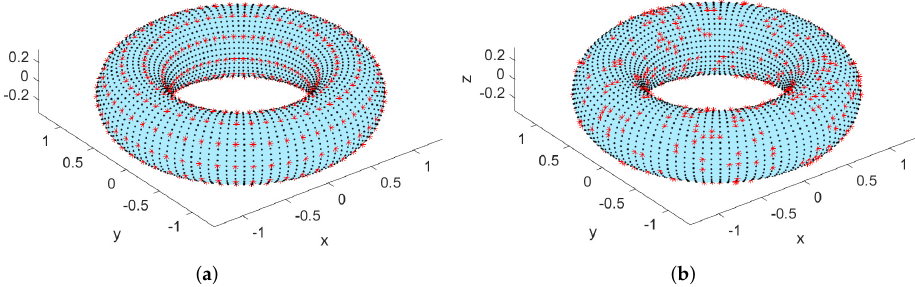
Figure 4. Example 2: Two different selections of training data on Torus: ( a ) quasi-uniform training data; ( b ) random training data generated by combined multiple recursive generator algorithm: red “*” points are selected training data; black points are test